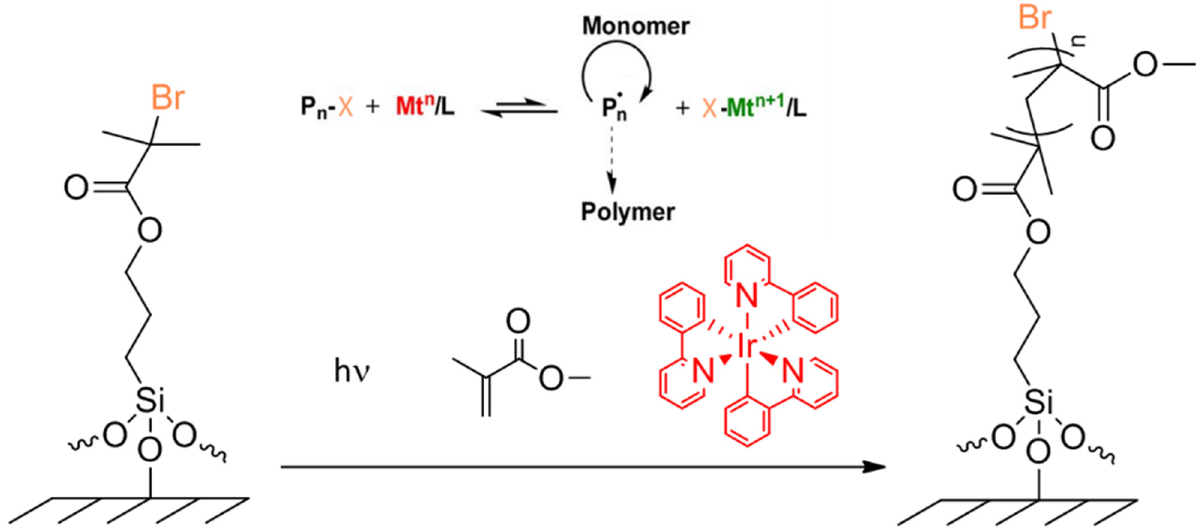
Figure 11. ATRP mechanism and “grafting from” photopolymerization of MMA on a silane-functionalized surface (modified from ref. [144]). The ATRP initiator is labeled in orange, and the photoredox catalyst (Mt n /L = Ir(ppy) 3 ) is labeled in red.